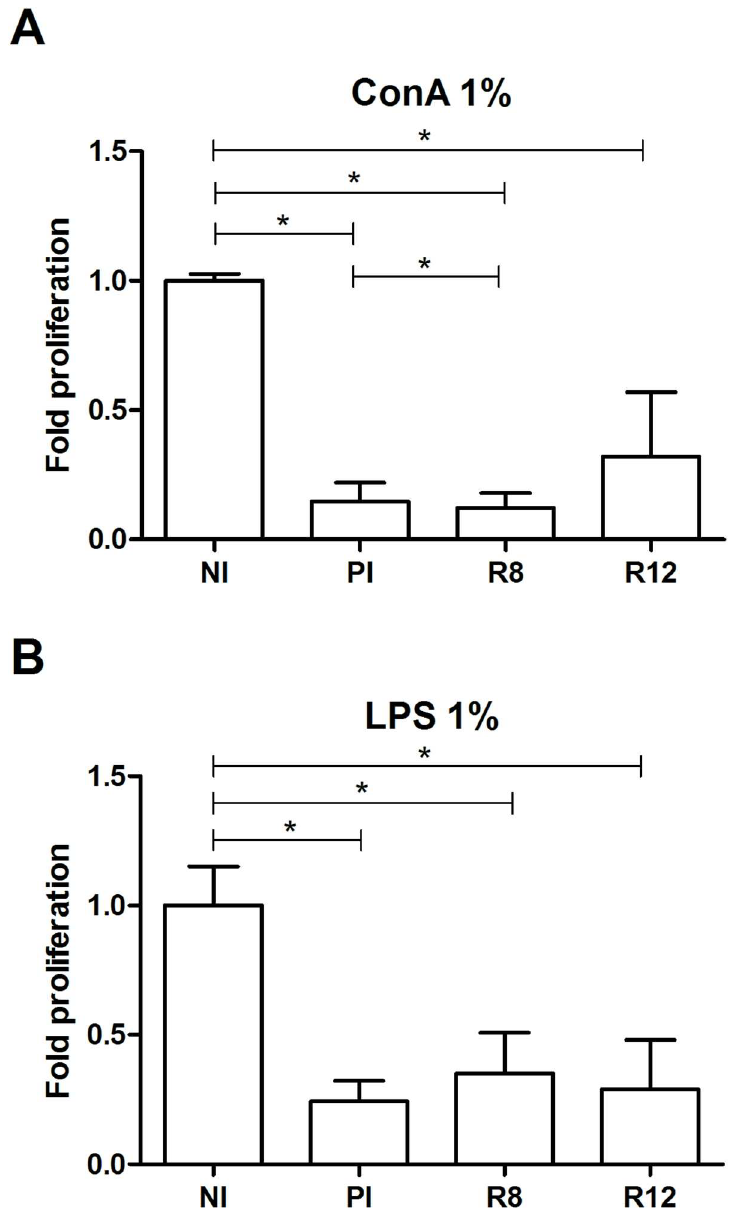
Fig 7. Effect of Fasciola hepatica reinfection on spleen cell proliferation in response to mitogens. A) Concanavalin A (ConA). B) Lipopolysaccharide (LPS). Group NI: uninfectedcontrols; Group PI: rats received a singleinfection dose; Group R8: infected rats and challenged at 8 weeks after primary infection; Group R12: infected rats and challenged at 12 weeks after primary infection. Significantinhibition of the proliferation were observedin cultures stimulatedwith concanavalin A (ConA) and lipopolysaccharide (LPS). P < 0.05 was considered to be statistically significant.Bars represent mean ± SD. * Statistically significantdifferences (P < 0.05,Mann-Whitney non-parametric